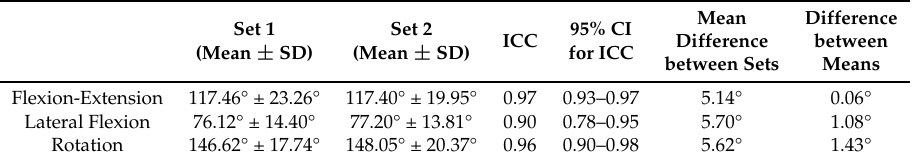
Table 4. Results for the two sets of motions performed with the second sensor located in T4 considering full